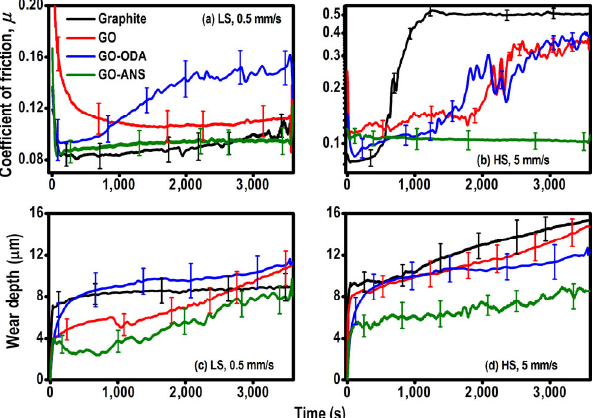
Fig. 9 Variation in friction coefficient with time data for graphite, GO, GO-ODA and GO-ANS in the ambient from the (a) low speed (0.5 mm/s), (b) high speed (5 mm/s) and corresponding wear depth with sliding time data from the (c) low speed, (d) high speed microtribometric ball loading studies at normal load of 5 N ( P m = 1.1 GPa) with sliding stroke length of 4